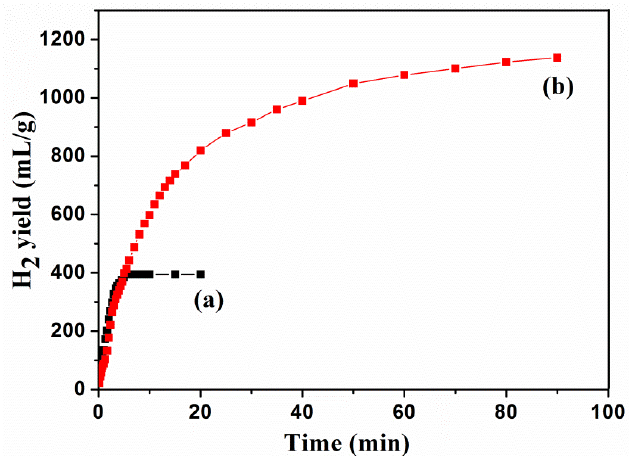
Figure 9. The hydrogen evolution curves by hydrolysis of 3 h ball-milled MgH 2 in pure water (a) and in 0.05M MgCl 2 solution